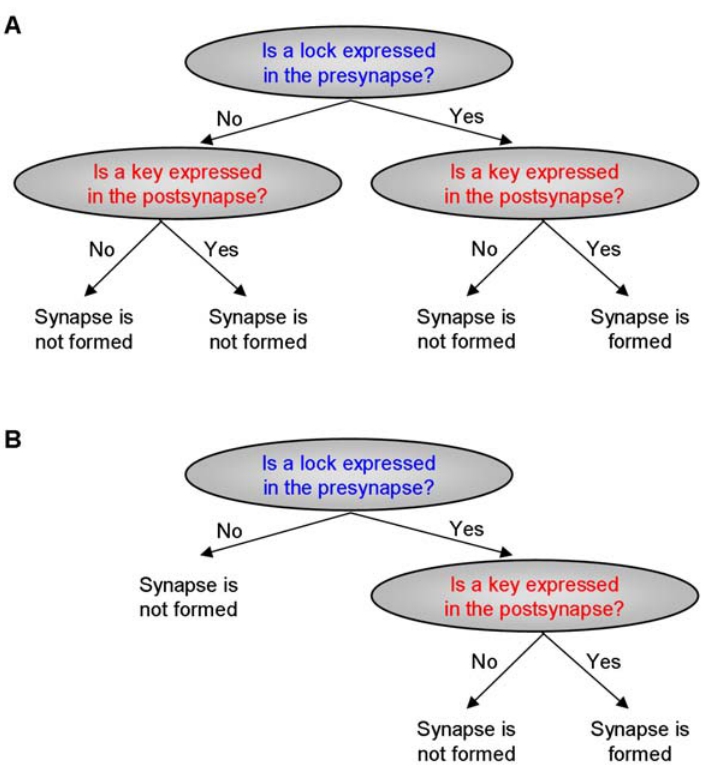
Figure 1. Context Specific Independencies Reduce the Complexity of the Model and Make It Easier To Interpret. (A) A complete decision tree for the simplified example of a lock-and-key molecular identifiers mechanism: only when the presynaptic neuron expresses a lock molecule and the postsynaptic neuron expresses a key molecule, a synapse is formed between them. (B) A simpler decision tree that captures the same logic but exhibits context specific independence. In the context in which the lock is not expressed in the presynaptic neuron, the formation of a synapse between adjacent neurons is independent of the expression of the key in the postsynaptic neuron.